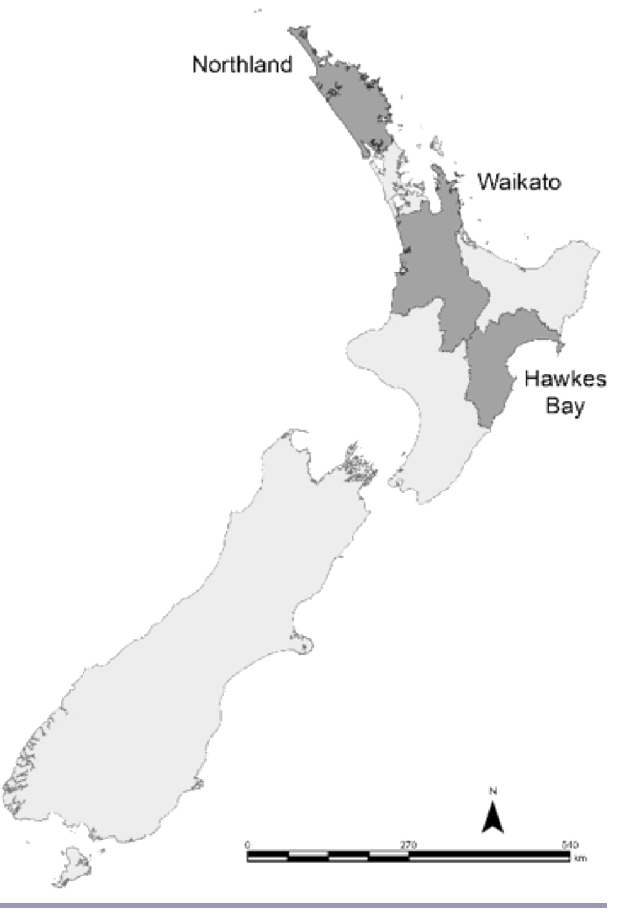
Fig. 2 . Hawke’s Bay. The T ū taekuri, Ahuriri, Ngaruroro and Karam ū catchments are